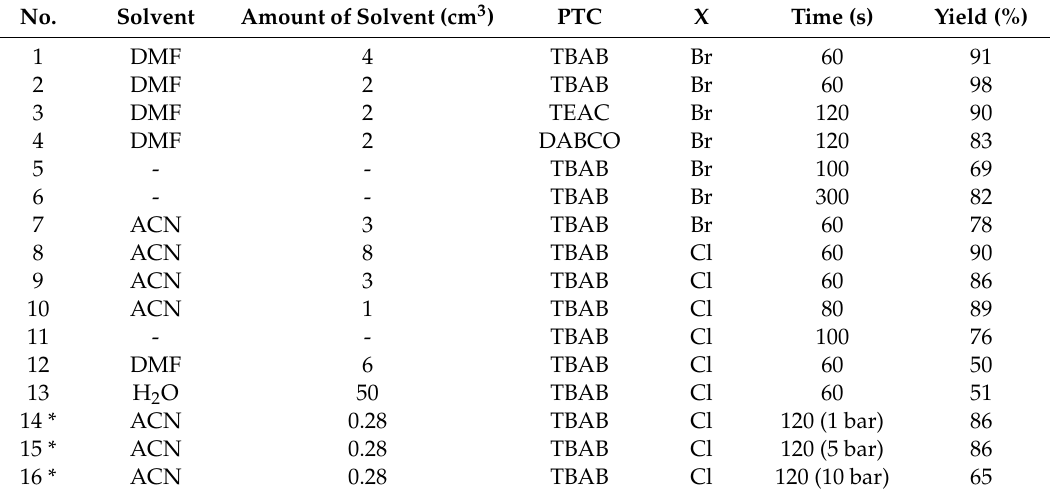
Table 2. Synthesis of trazodone with method I—10 mmol of